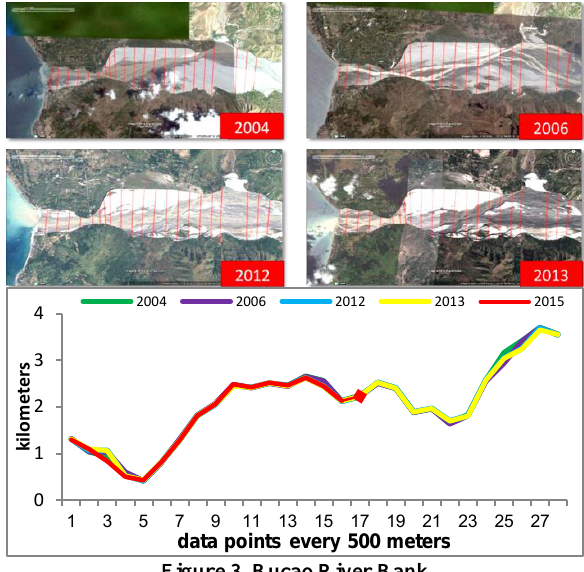
Figure 3. Bucao River